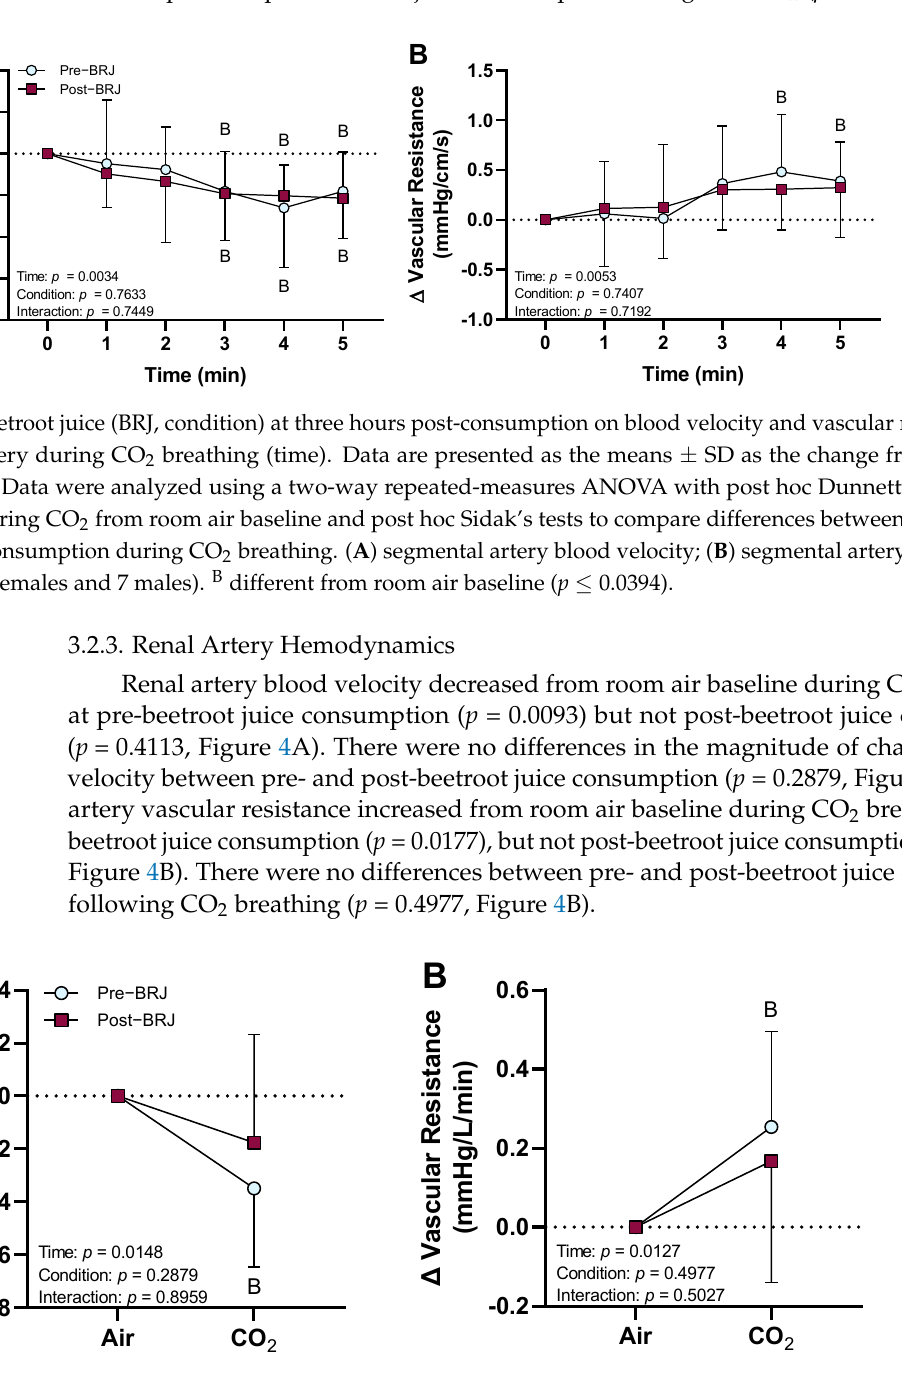
Figure 4. Effect of beetroot juice (BRJ, condition) at three hours post-consumption on blood velocity and vascular resistance in the renal artery during five minutes of CO 2 breathing (time). Data are presented as the means ± SD as the change from room air baseline. Data were analyzed using a two-way repeated-measures ANOVA with post hoc Sidak’s tests to compare changes from room air baseline and to compare differences between pre-and post-beetroot juice consumption during CO 2 breathing. ( A ) renal artery blood velocity; ( B ) renal artery vascular resistance. n = 10 (4 females and 6 males). B different from room air baseline ( p ≤ 0.0177).